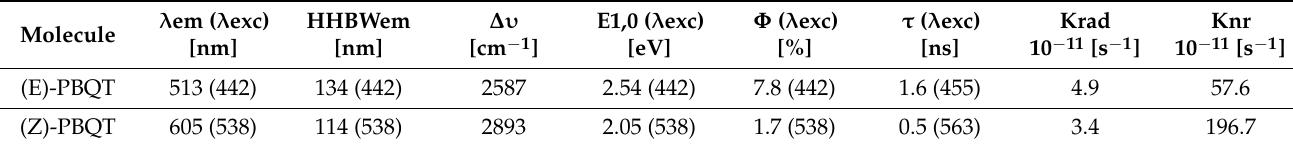
Figure 7. ( a ) PBQT emission spectra at different irradiation times, it is observed that when the solution is irradiated, the fluorescence intensity decreases and the red shifts. ( b ) Fluorescence spectra of PBQT in chloroform before and after irradiation; ( c ) PBQT solutions under the UV lamp before and after irradiation; note an evident change in the emission colour of PBQT . Table 3. Fluorescence optical properties in CHCl 3 of the polymer PBQT.